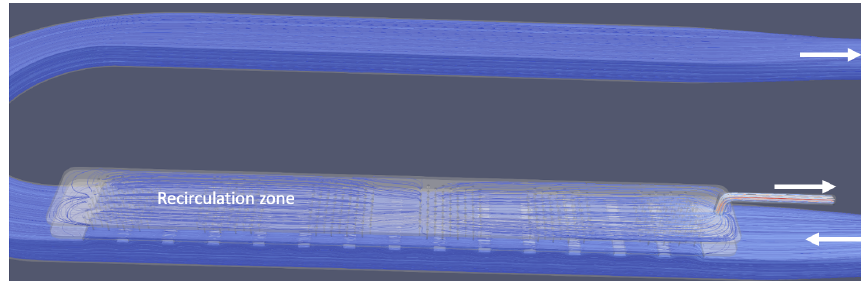
Figure 14. Large recirculation zone in device design with only one